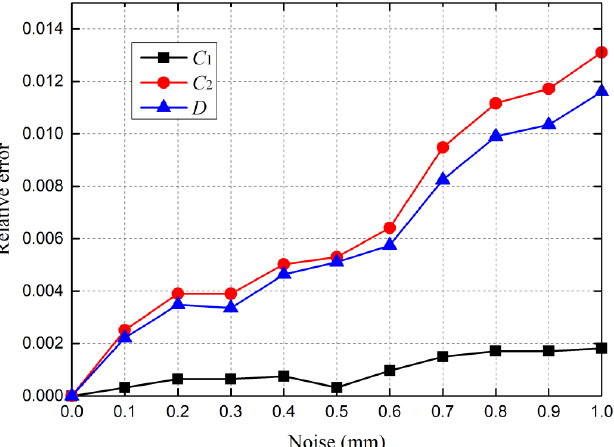
Figure 8. Influence of image noise on the calibration accuracy.